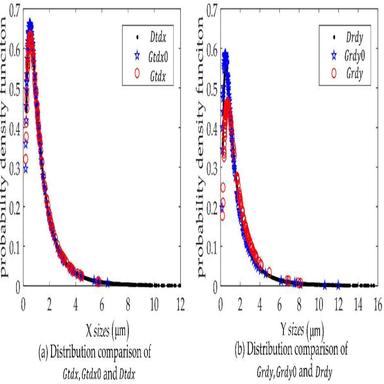
Pseudorandom 2D grain geometries.